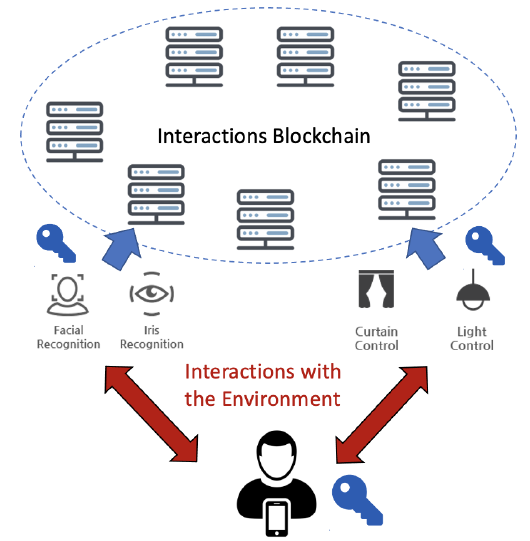
Figure 1. Secure Path: interactions among users and IoT devices are signed and stored in the